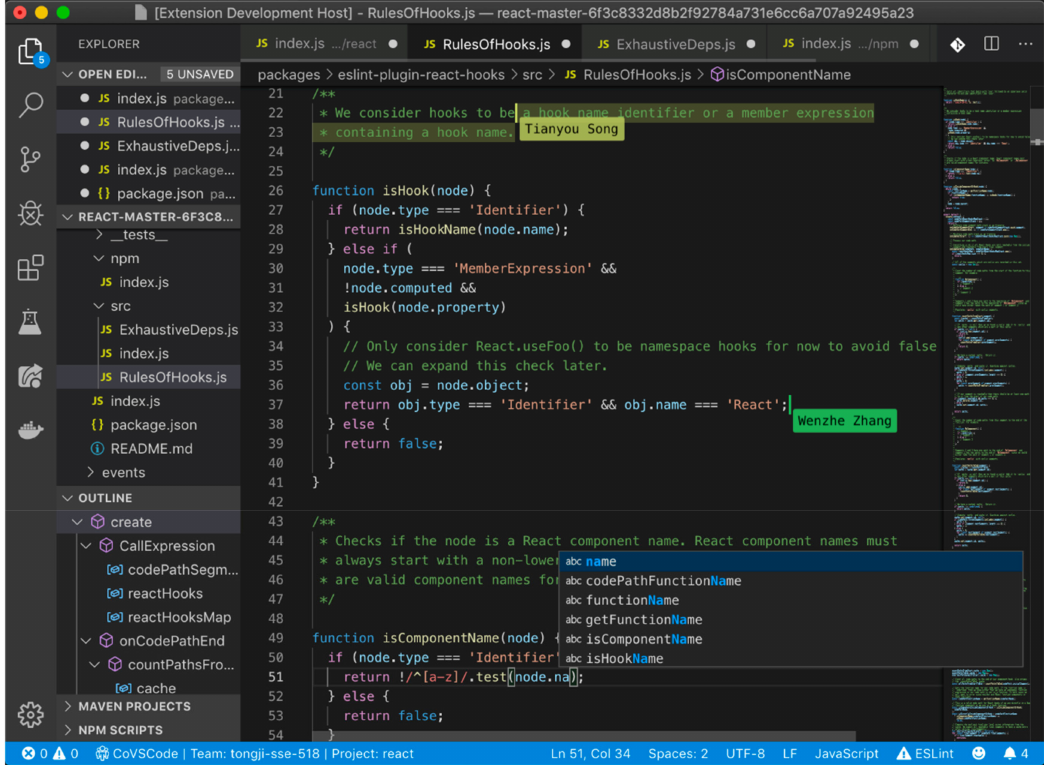
Figure9. UIsnapshotofthe CoVSCode